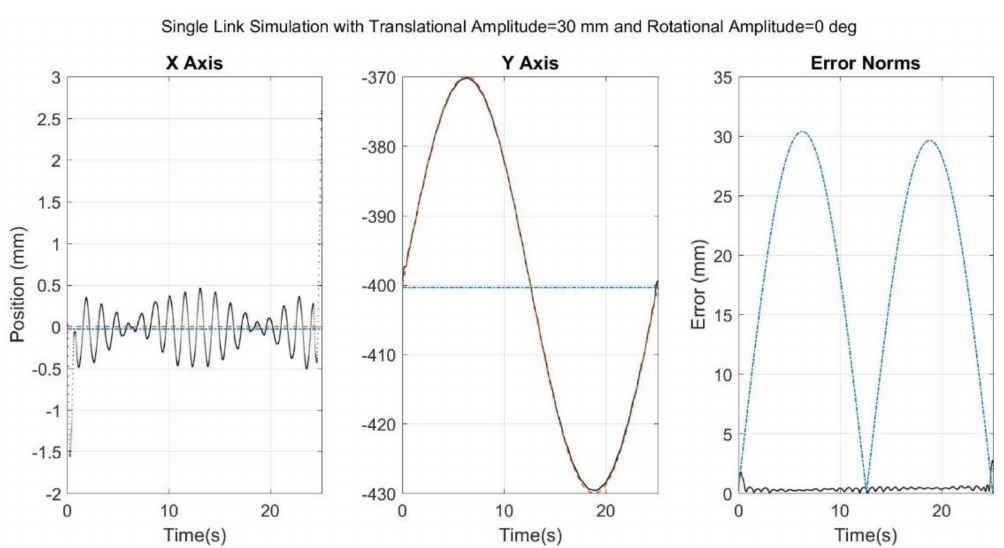
Figure 7. Results for simulation run with noise added to the rigid link as well as spring-induced relative translational motion of the sensor. Black dots refer to SFO, blue dash-dots to SOM, and red dashes to the theory. Note that the SFO and theory results exhibit significant overlap.